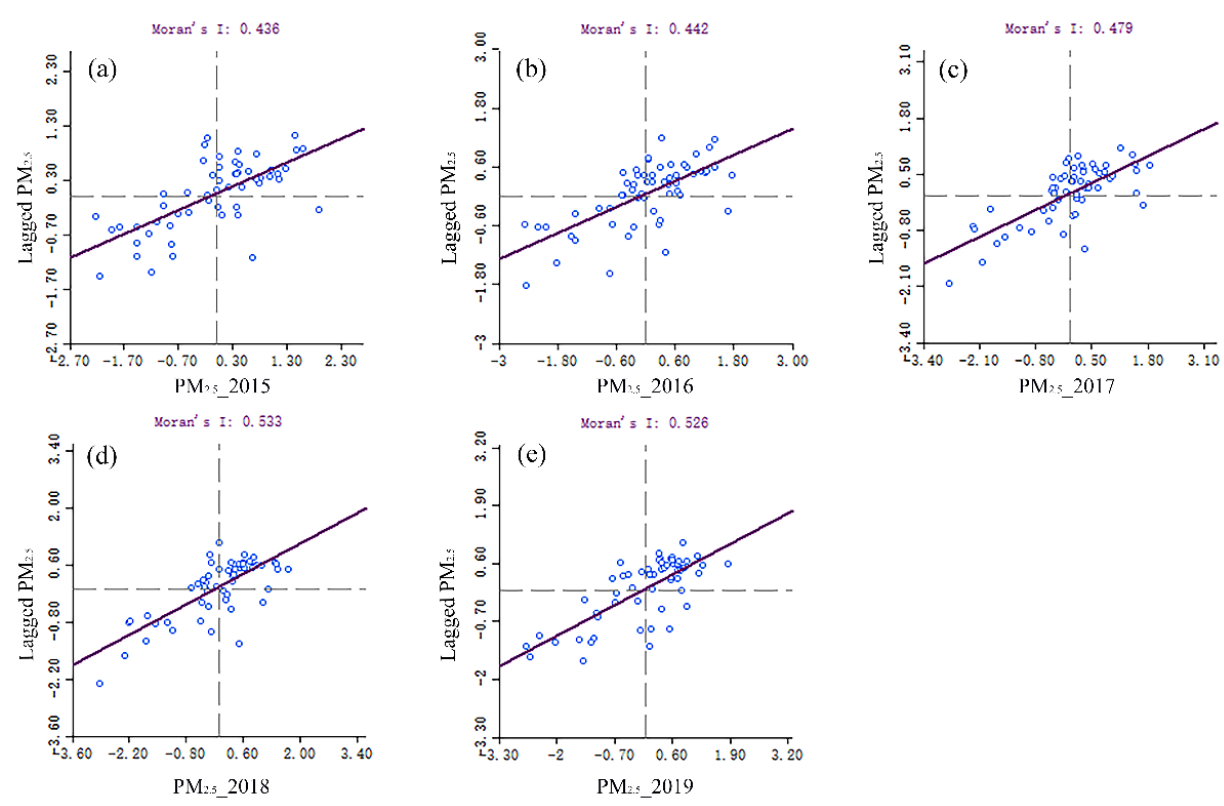
Figure 4. Moran scatter diagram from 2015 to 2019. ( a ) 2015; ( b ) 2016; ( c ) 2017; ( d ) 2018; ( e ) 2019.